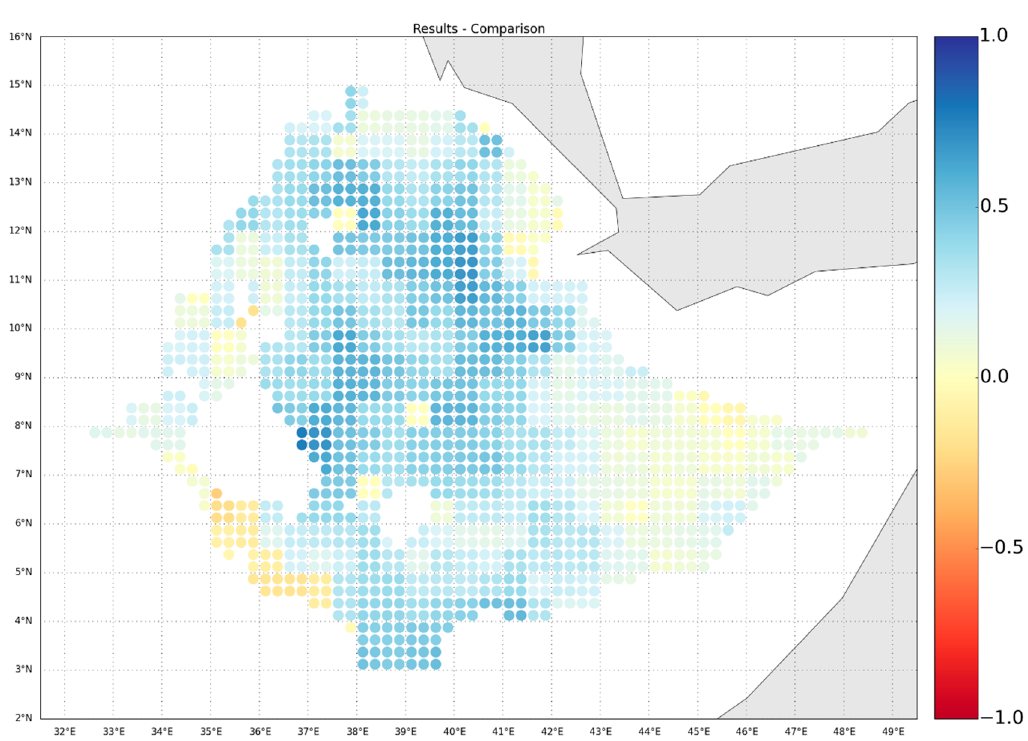
Figure 7. Comparison of SPEI and scPDSI from 1992 to 2012: average Pearson’s R : 0.28, and average Stdv: 0.18. Regions with dense vegetation or complex topography and lakes are masked.